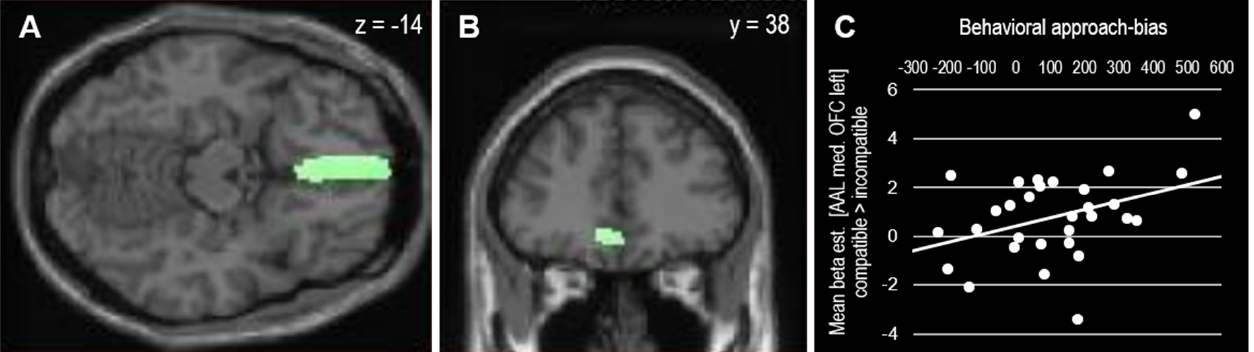
Figure 4. ( A , B ) Mask (AAL medial OFC left) used for SVC ( p svc = 0.023 FWE-corrected at cluster